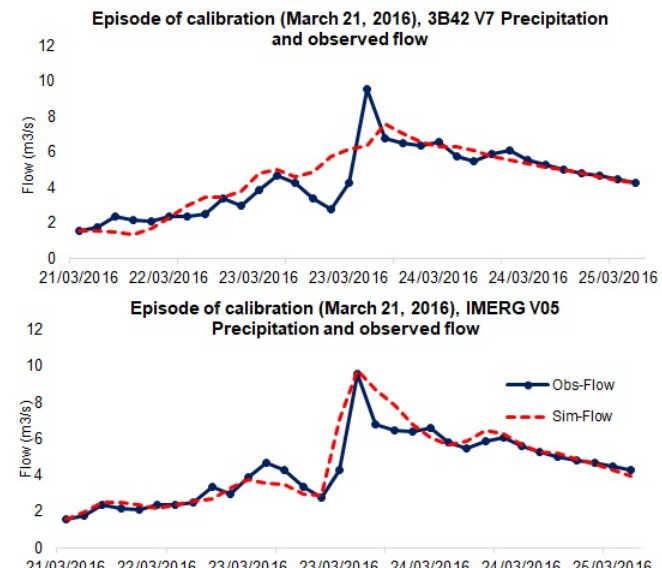
Figure 4. Calibration of the episode 21 March 2016, using 3B42V7 and IMERG V05 rainfall products and observed runoff data as input.